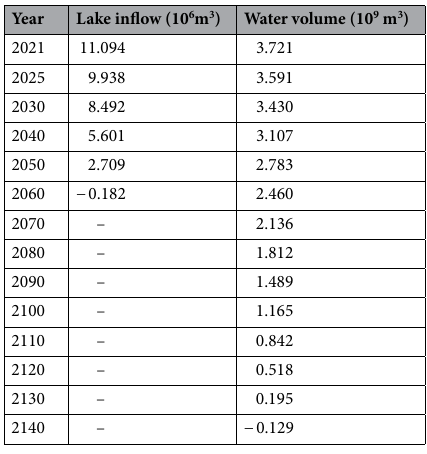
Table 7. Future prediction of Daihai Lake in situation